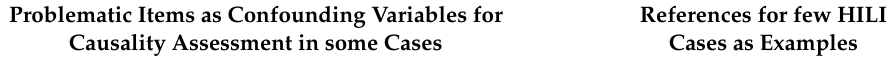
Table 10. Confounding variables as examples in case reports of HILI.